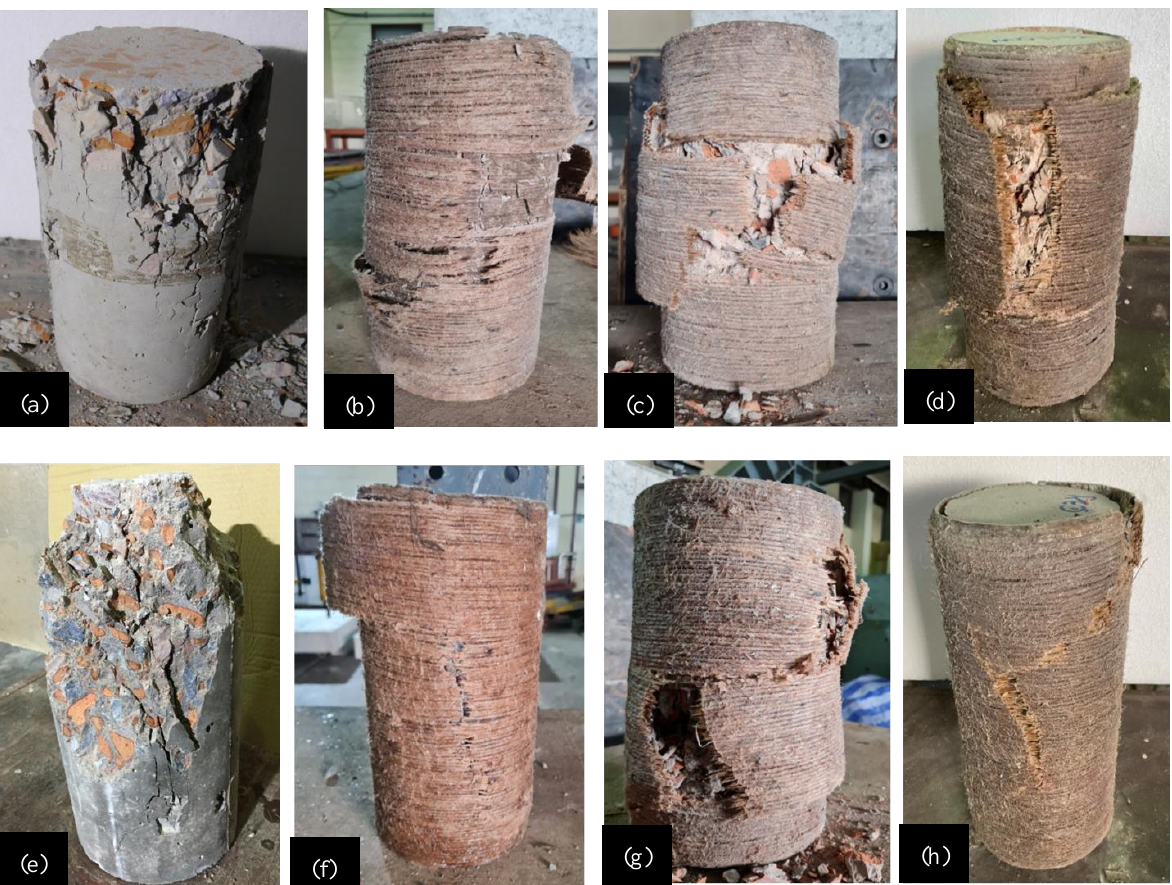
Figure 11. Ultimate failure pattern of specimens: ( a ) C-LS-CBB-CON, ( b ) C-LS-CBB-1H, ( c ) C-LS-CBB-2H, ( d ) C-LS-CBB-3H, ( e ) C-HS-CBB-CON, ( f ) C-HS-CBB-1H, ( g ) C-HS-CBB-2H, and ( h ) C-HS-CBB-3H.